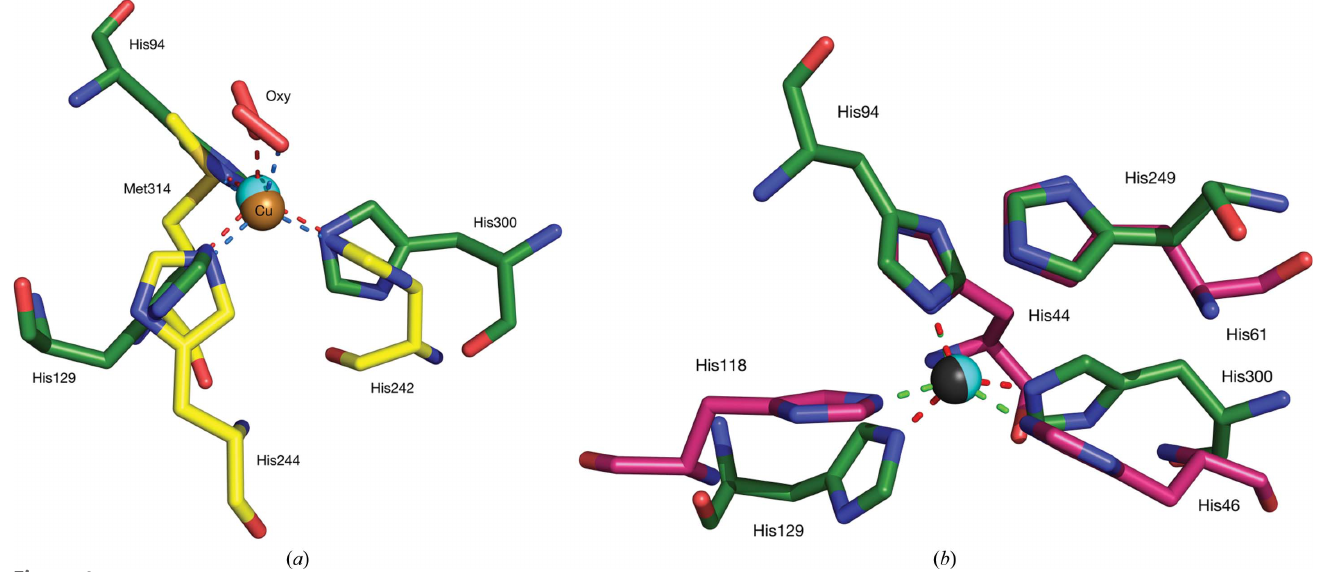
Figure 4 Copper-site comparison of dioxygen-binding enzymes. ( a ) Superposition of the SF-ROX Ax NiR resting-state T2Cu site and dioxygen-bound PHM. Ax NiR is shown in green and PHM is shown in yellow, with the Cu atoms shown in cyan and brown, respectively. Ax NiR coordinate bonds are shown in red, with PHM coordinate bonds shown in blue. PHM is from PDB entry 1sdw (Prigge et al. , 2004). The PHM copper has His 2 –Met coordination. Both structures have an end-on-bound dioxygen (shown in red). ( b ) Superposition of the SF-ROX Ax NiR resting-state T2Cu site and the reduced bovine SOD Cu site. Ax NiR is shown in green and Cu,Zn-SOD is shown in purple, with their Cu atoms shown in cyan and dark grey, respectively. Ax NiR coordinate bonds are shown in red, with SOD coordinate bonds shown in green. Bovine Cu,Zn-SOD is from PDB entry 1q0e (Hough & Hasnain, 2003). The copper sites display similar His 3 ligation. The NiR His CAT occupies a similar position to the SOD bridging